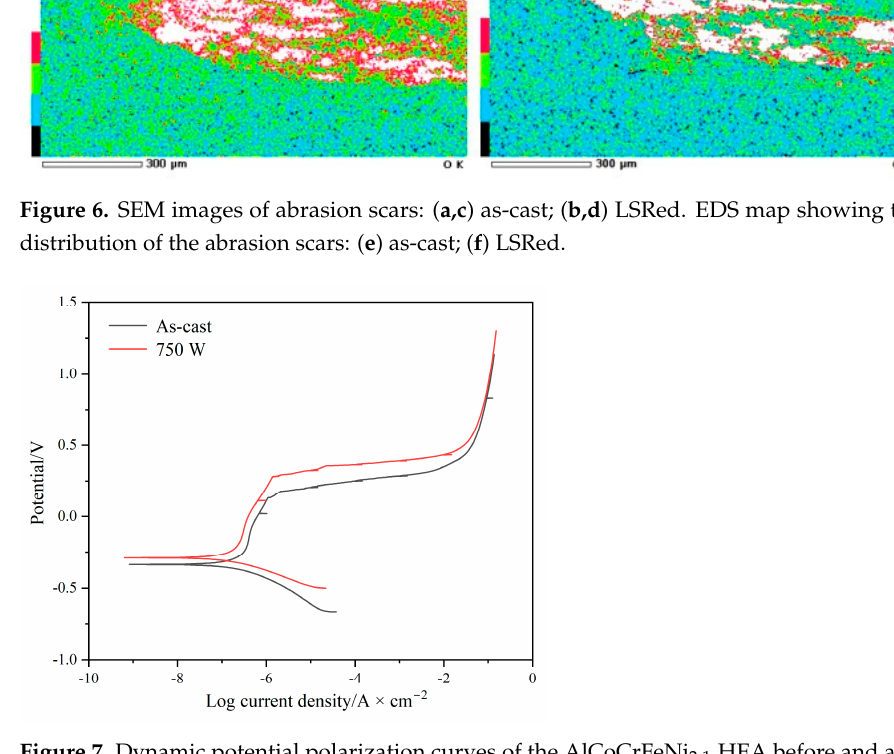
Figure 7. Dynamic potential polarization curves of the AlCoCrFeNi 2.1 HEA before and after LSR.